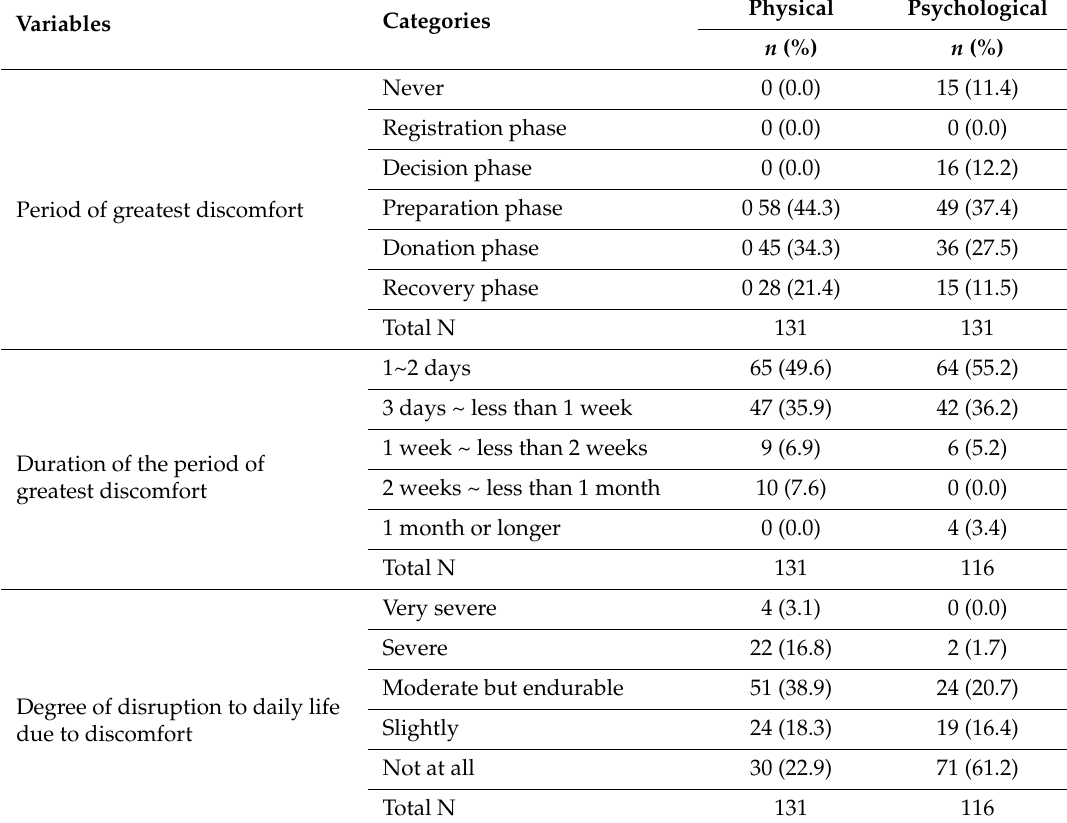
Table 3. Discomfort period, duration, and degree of disruption to daily life (N =